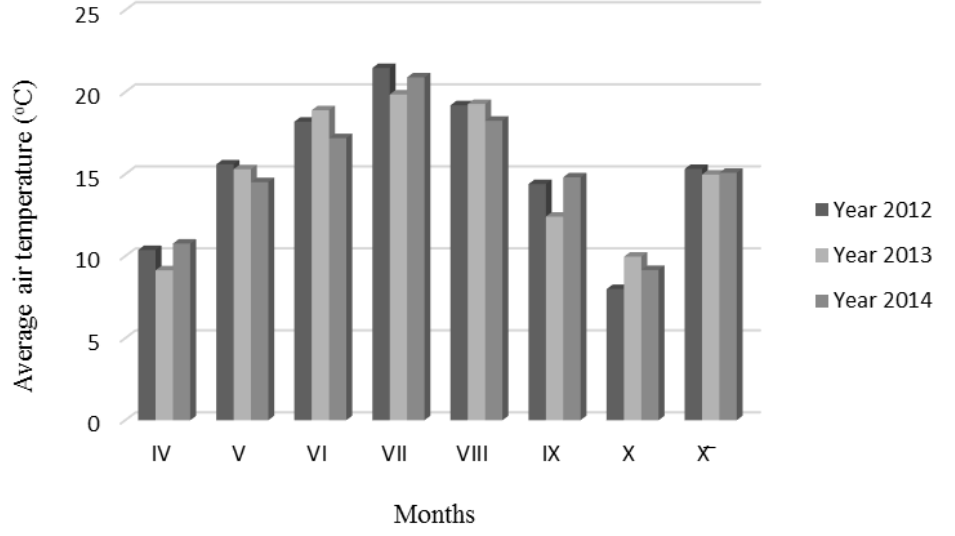
Figure 2. IV—April, V—May, VI—June, VII—July, VIII—August, IX—September, X—October, X— Figure 2. IV — April, V — May, VI — June, VII — July, VIII — August, IX — September, X — October, Average for the 𝑋̅ Average for the season Figure 2. Monthly average daily air temperature during the growing season in the years 2012 – 2014 (based on data from the meteorological station of the Soska Konsulting).